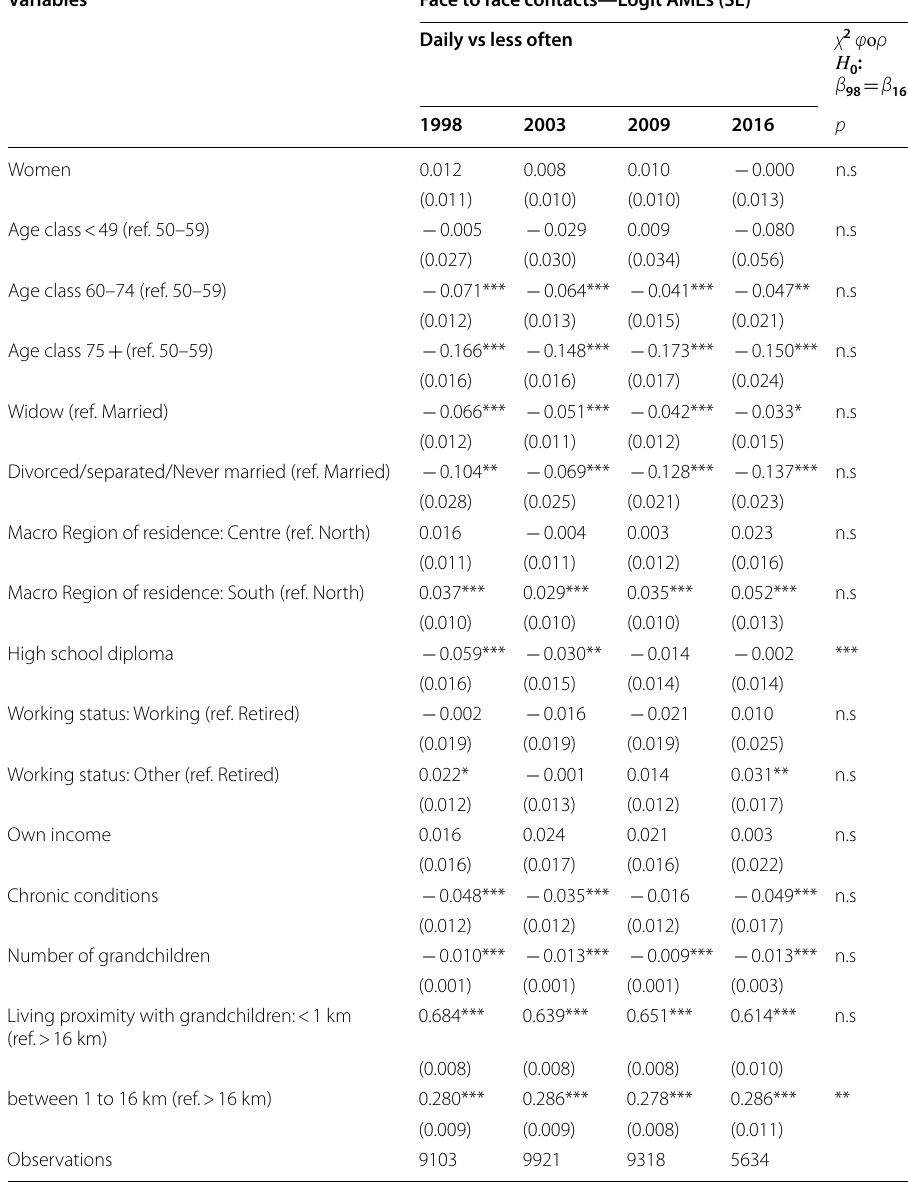
Table 3 Logistic regression models estimating the Average Marginal Effects (AMEs) of daily contacts with grandchild among all grandparents by